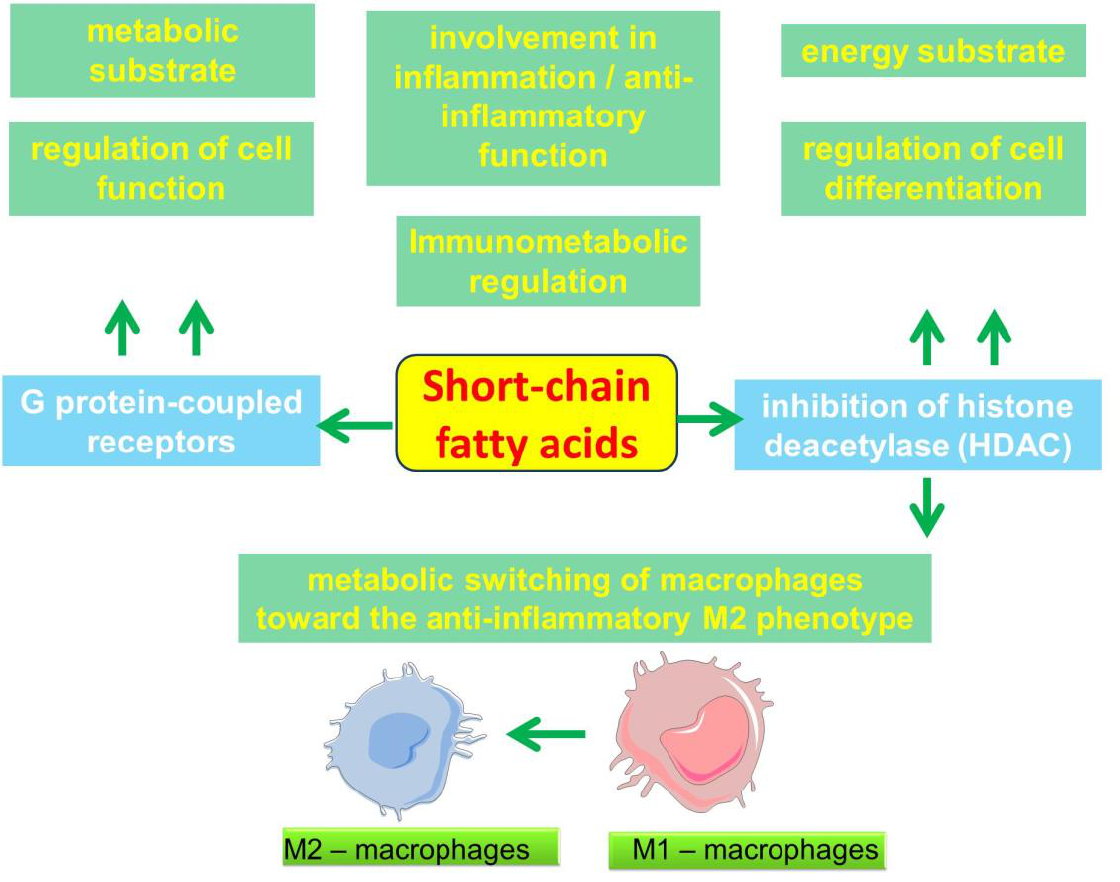
Figure 2. Scheme of the involvement of short-chain fatty acids in cell function and inflammation.